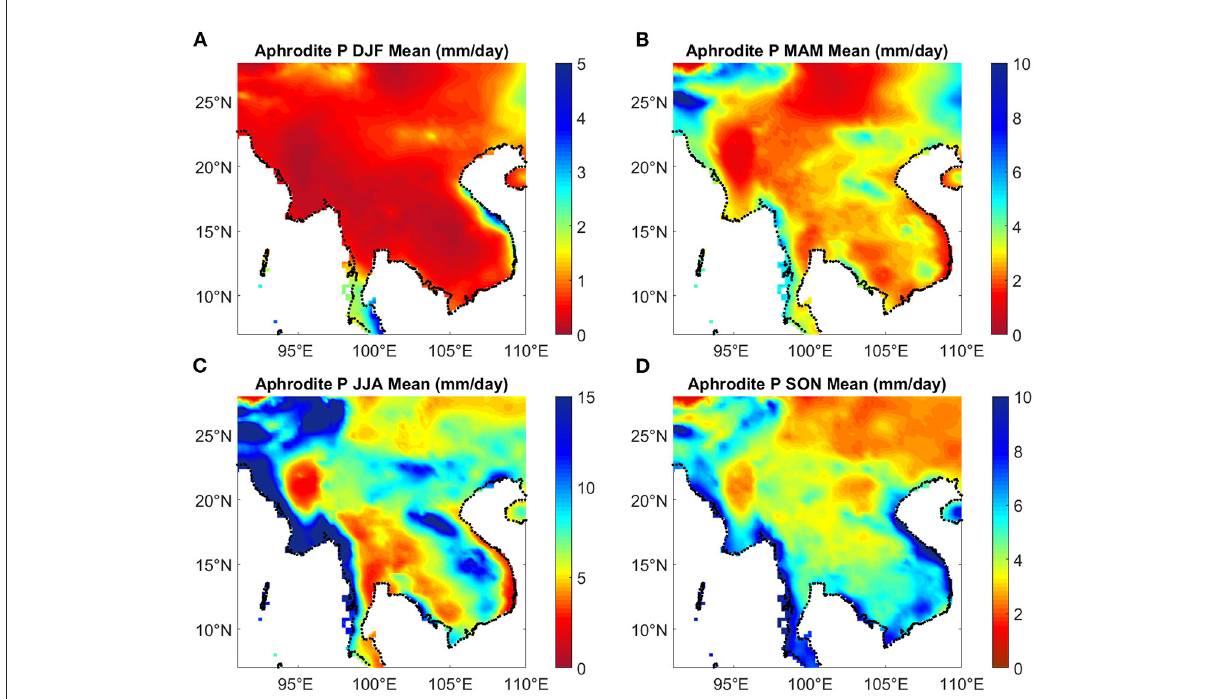
FIGURE2 Climatological mean seasonal precipitation patterns over MSEA based on the rain-gauge-based APHRODITE dataset: (A) Winter (Dec–Feb); (B) Spring (Mar–May); (C) Summer (Jun–Aug); (D) Autumn (Sep–Nov).